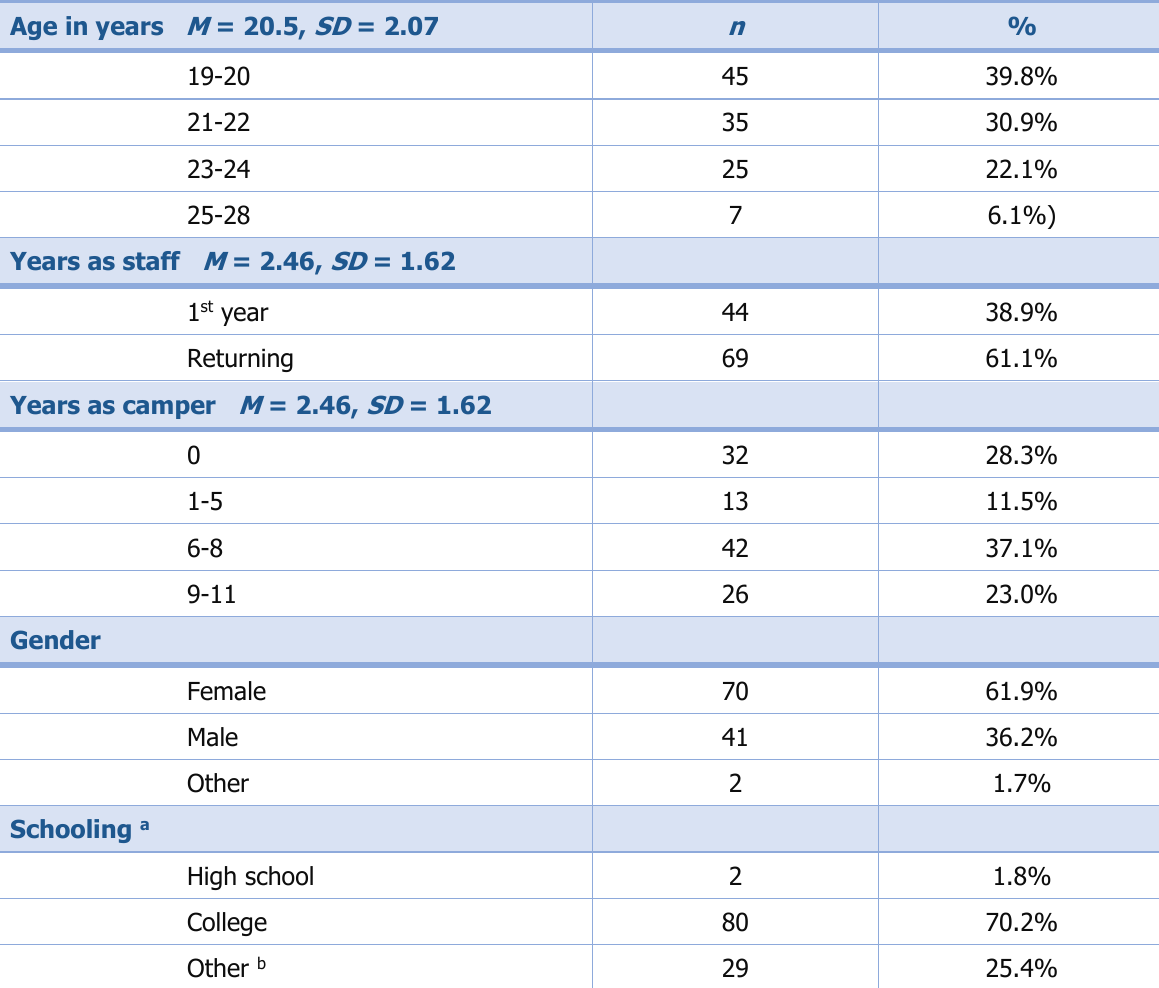
Table 1 Characteristics of Study Participants (n = 113) Age in years M = 20.5, SD = 2.07 n % 19-20 45 39.8% 21-22 35 30.9% 23-24 25 22.1% 25-28 7 6.1%) Years as staff M = 2.46, SD = 1.62 1 st year 44 38.9% 69